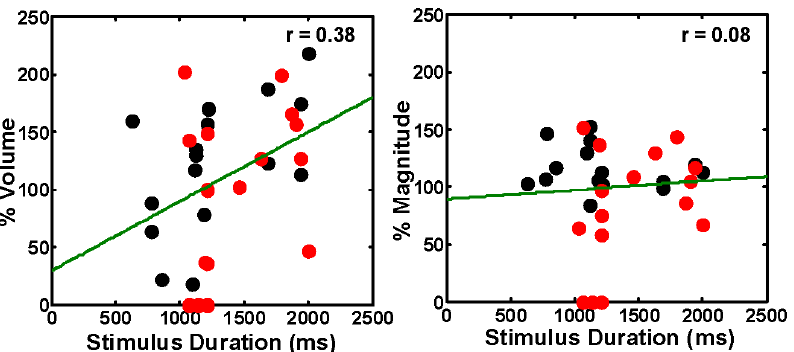
Figure 4. Absence of significant high correlation between the stimulus duration and BOLD response. Plots of % volume and % magnitude of the BOLD response as a function of the song stimulus duration. The stimuli represented here are those that showed variable duration, namely BOS and TUT. The BOLD response does not show a significant high degree of systematic correlated change with the duration of the stimulus in repeaters (red dots) and in non-repeaters (black dots). The green lines depict linear fit to the data.